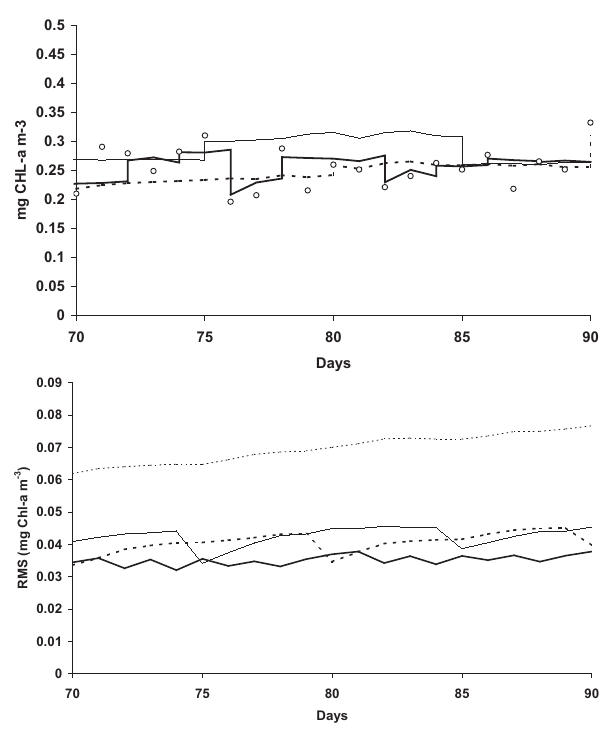
Fig. 11. (a) Assimilation of chlorophyll data at 2 ( ), 5 ( ) and 10 (- - -) day intervals upon the chlorophyll simulation at 65m depth compared with data ( ◦ ), (b) assimilation of chlorophyll data at 2 ( ), 5 ( ) and 10 (- - -) day intervals upon the RMS compared with the climatology (- - -).